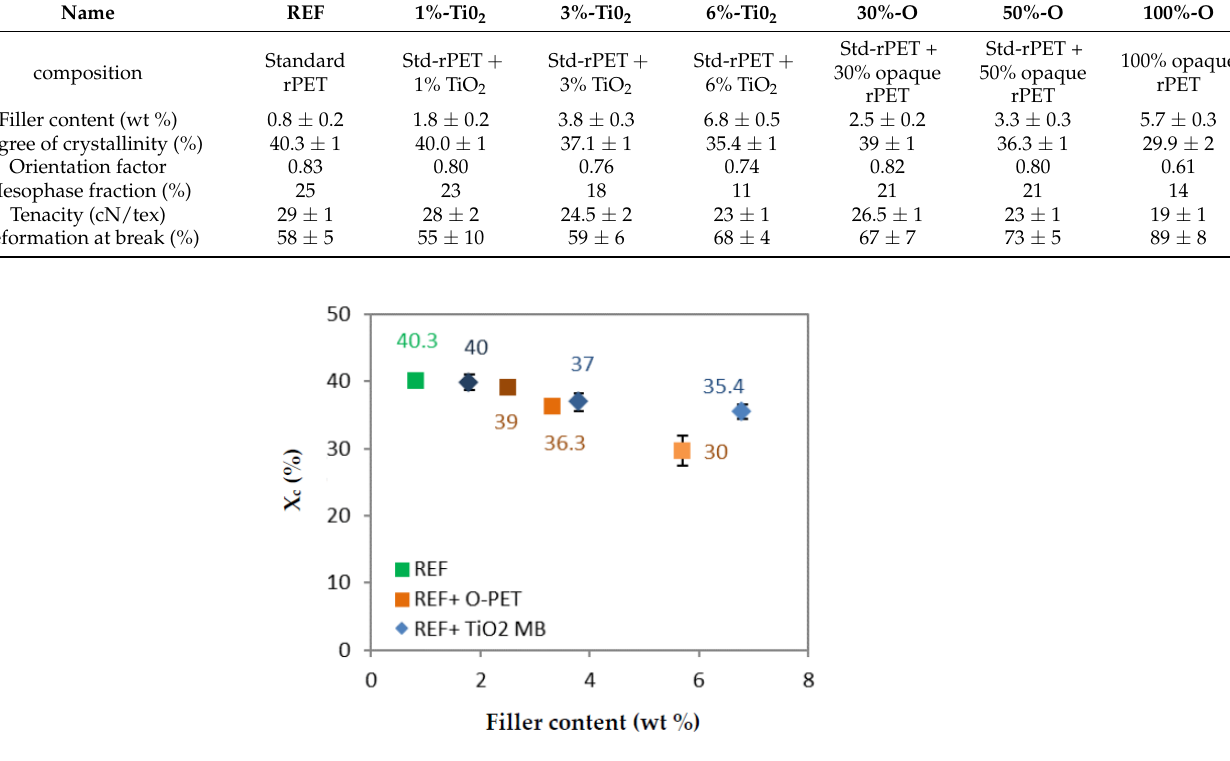
Figure 4. Degree of crystallinity (%) versus the filler content (wt %) for the two sets of filaments and the reference (green). Table 4. Main properties of the two sets of melt-spun filaments and the reference.